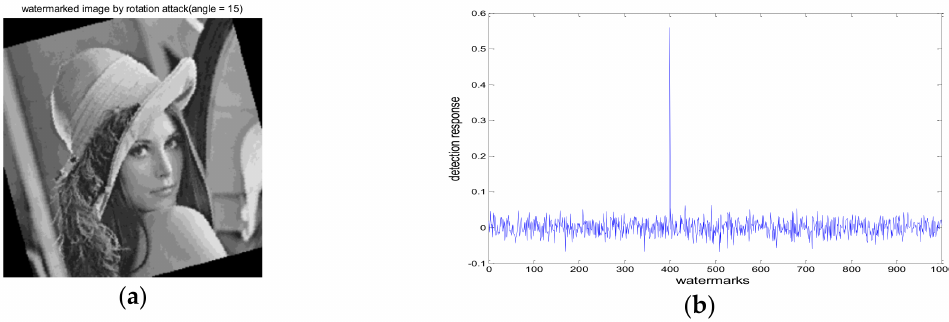
Figure 10. ( a ) Rotation attack (angle = 15 ◦ ); ( b ) detector